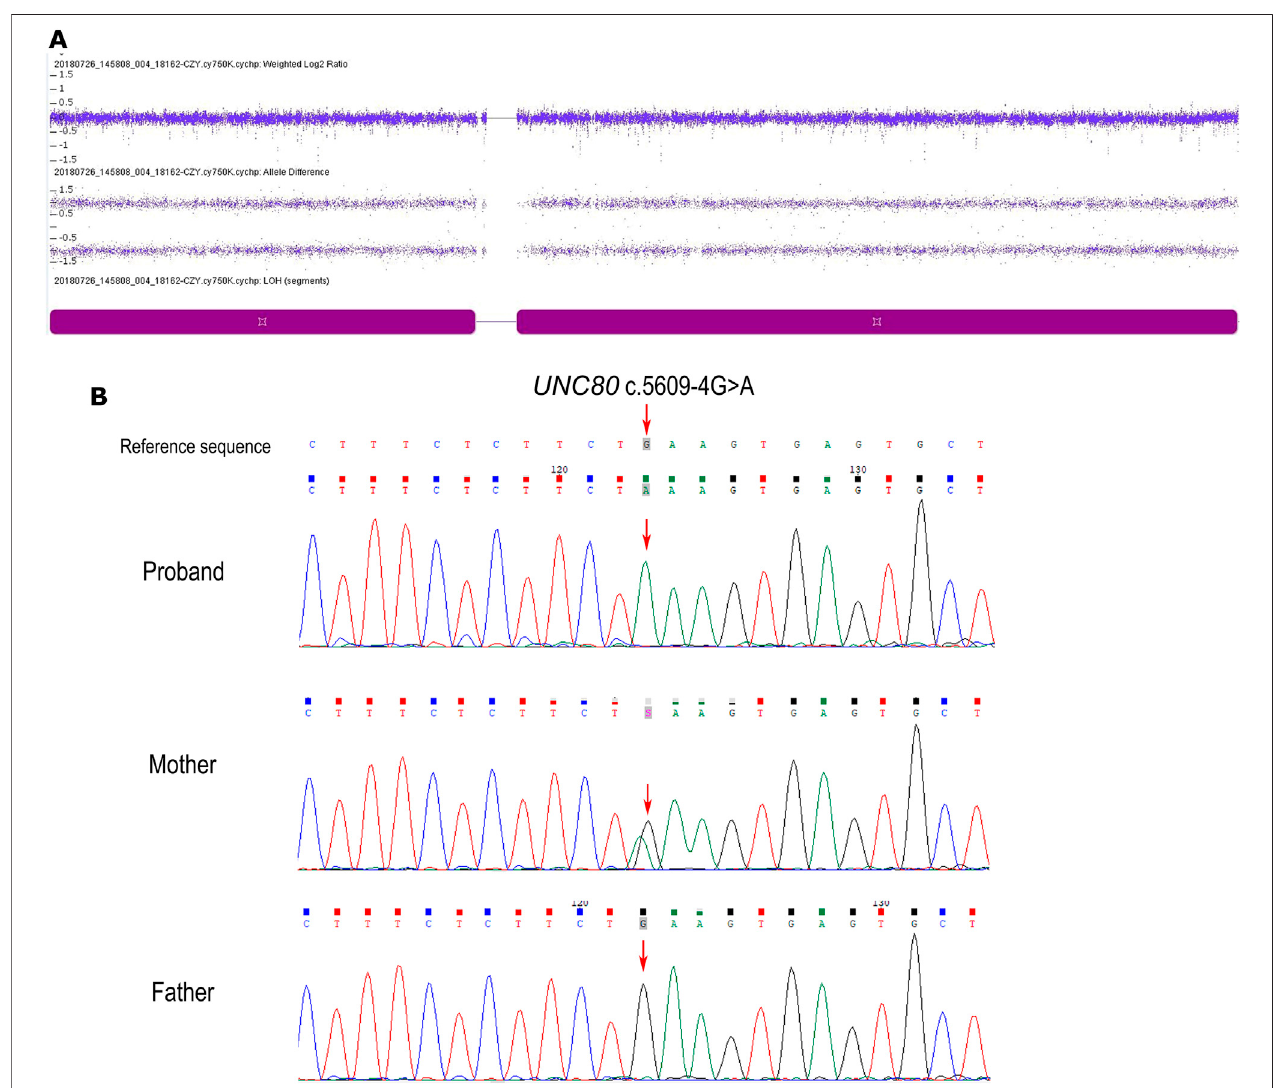
FIGURE 1 | (A) Single nucleotide polymorphism microarray (SNP array, Affymetrix Cytoscan 750k) pro fi les of chromosome 2 in the patient. The dark purple block indicatescompleteUPDinchromosome2,withtwoalleledifferencetrackswheretheplothasalineat+1and − 1. (B) Sequenceelectropherogramofthec.5609-4G > A variation showing (arrow) the homozygous mutation in the patient, the heterozygous genotype in his mother, and wild-type in his